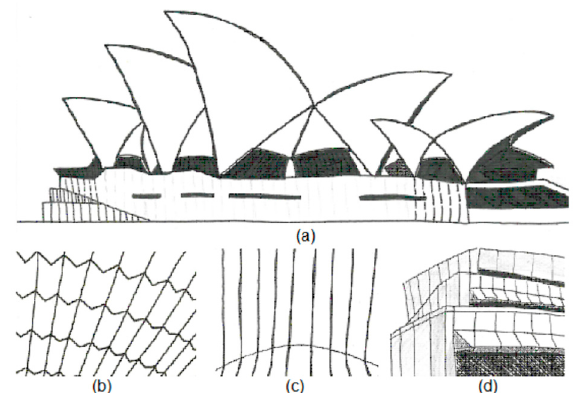
Figure 7. The Sydney Opera House as a less-living structure. Note: The scaling hierarchy of “far more smalls than larges” occurs only once ( a ), and the opera house shows monotonic repetition at many levels of scale or on each scale ( b – d ). The drawing is by Celine